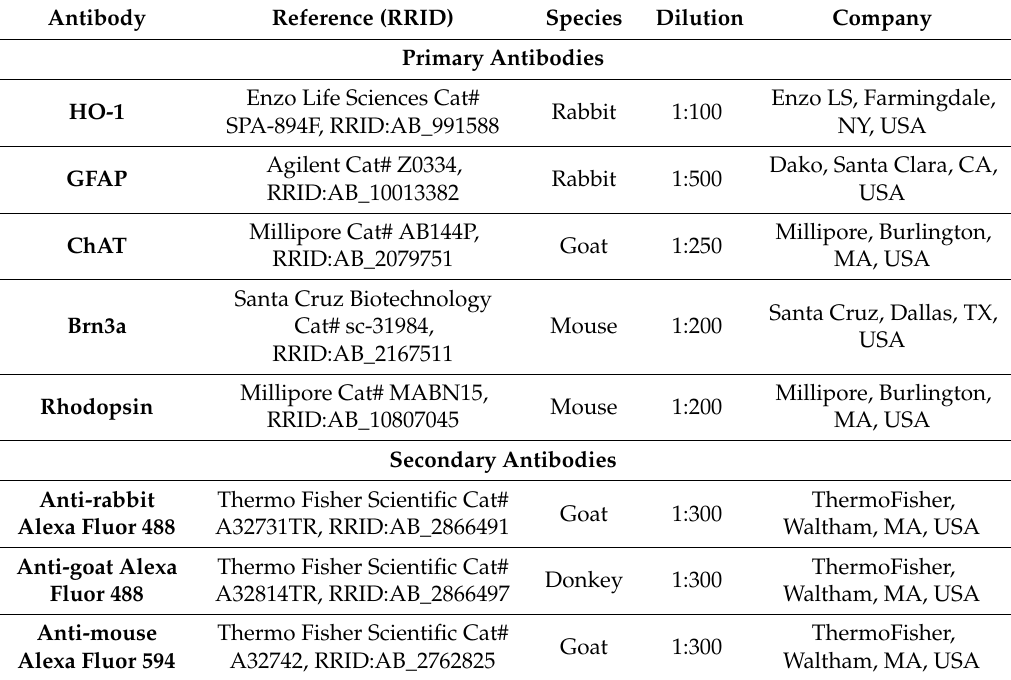
Table 2. Antibodies used in this